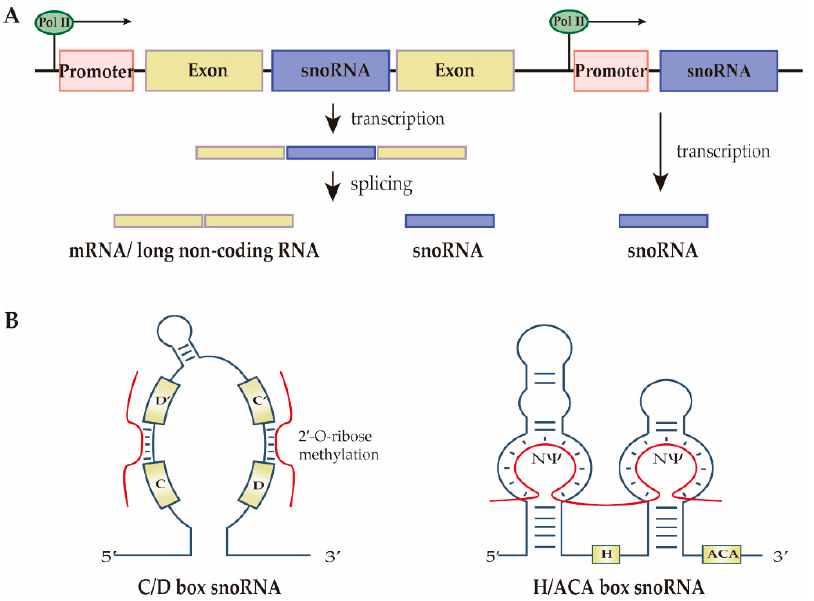
Figure 1. Biogenesis and structure of small nucleolar RNAs (snoRNAs). ( A ) SnoRNA biosynthesis. Most identified snoRNA genes are located in intronic regions of protein-coding genes or long non- coding sequences. They are transcribed by RNA polymerase II (Pol II) and are released from their transcripts after splicing. A small subset of snoRNAs is produced from single genes with independent promoters. ( B ) SnoRNA structure. C/D box snoRNAs have two conserved sequences, namely box C (RUGAUGA) and box D (CUGA). The upstream of box D’/D is complementary to the target RNAs and guides the 2 (cid:48) -O-ribose methylation. H/ACA box snoRNAs contain conserved H box (ANANNA) and ACA box. They also have two pseudouridylation (N Ψ ) pockets complementary to the target RNAs to direct their pseudouridine